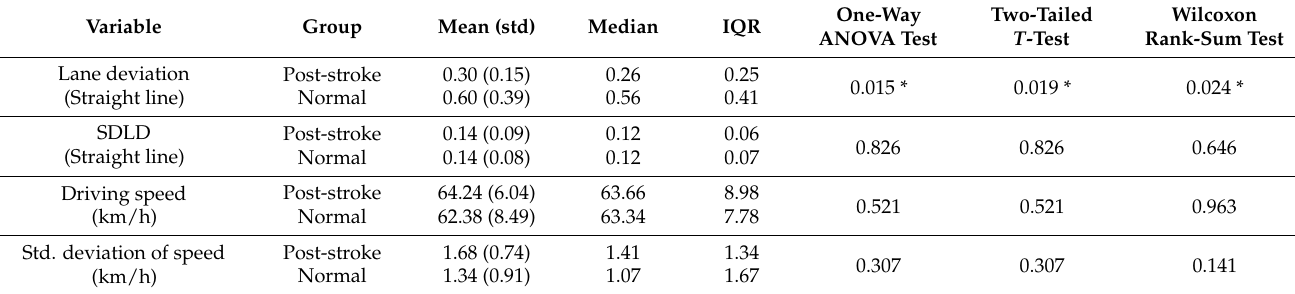
Table 5. Statistical tests of lane keeping and speed control in straight line section